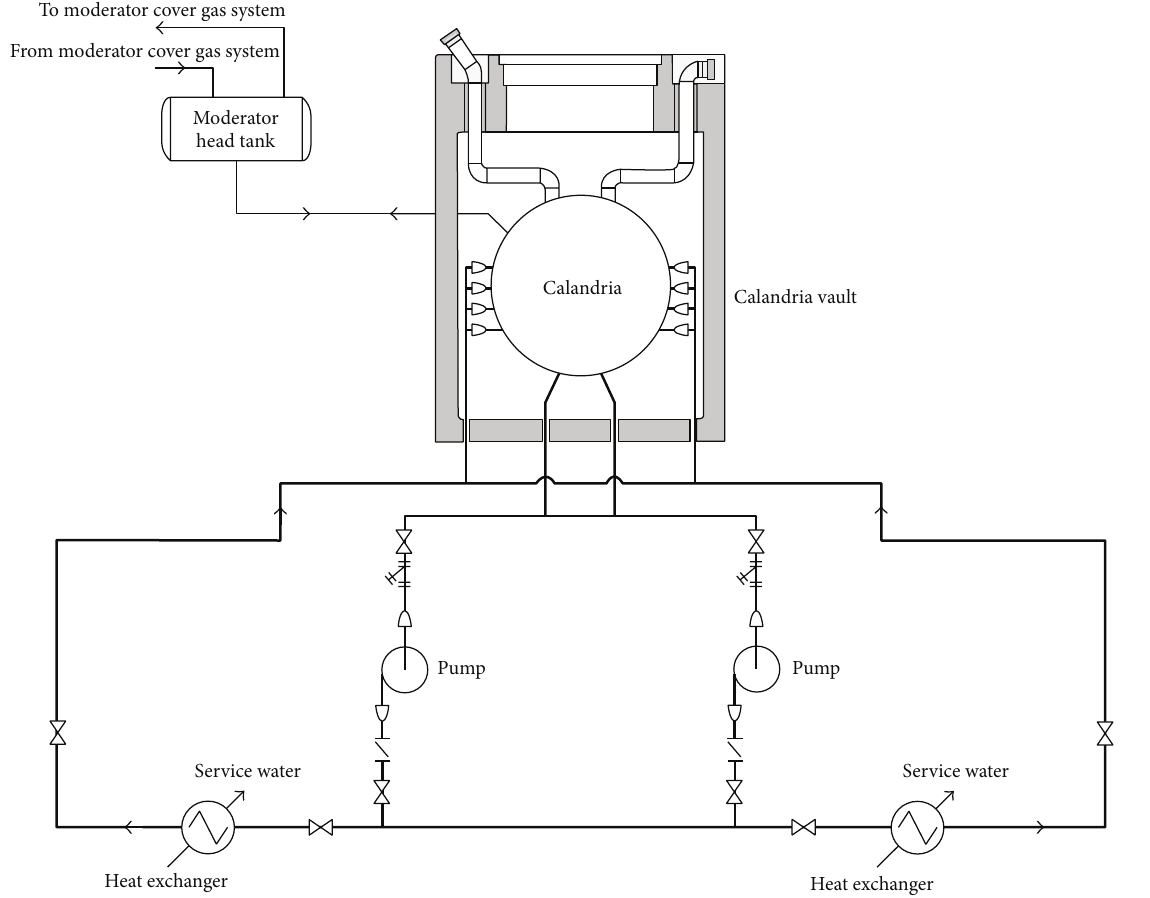
Figure 1: Configuration of the moderator circulation